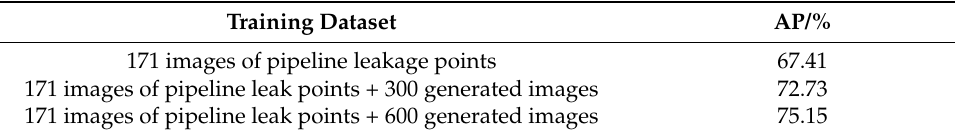
Table 2. Identification Table 2. Identi fi cation results.